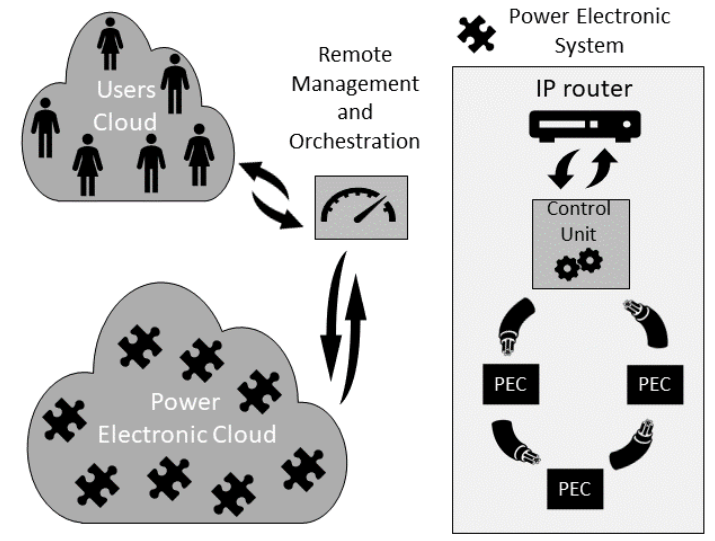
Figure 2. The daisy chain control scheme (right inset) as an element of the power electronic